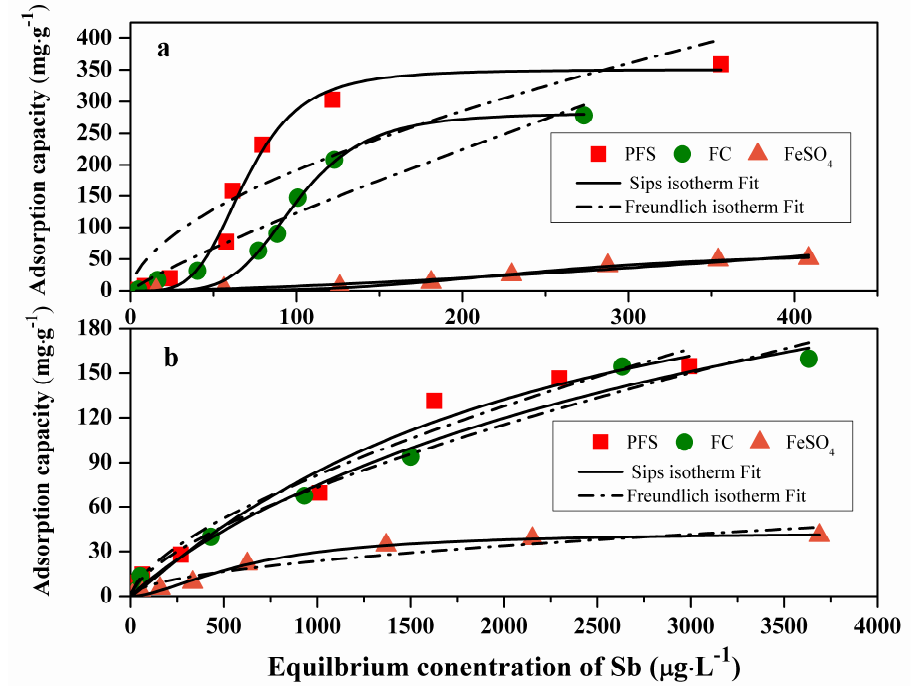
Figure 3. Coagulation of ( a ) Sb(III) and ( b ) Sb(V) by PFS, FC, and FeSO 4 fitted with Freundlich and Sips isotherms (dosage of coagulants as Fe: 10 mg · L − 1 Table 1. Constants of Freundlich and Sips isotherms for Sb(III) and Sb(V) adsorption on hydrous ferric oxide flocs.